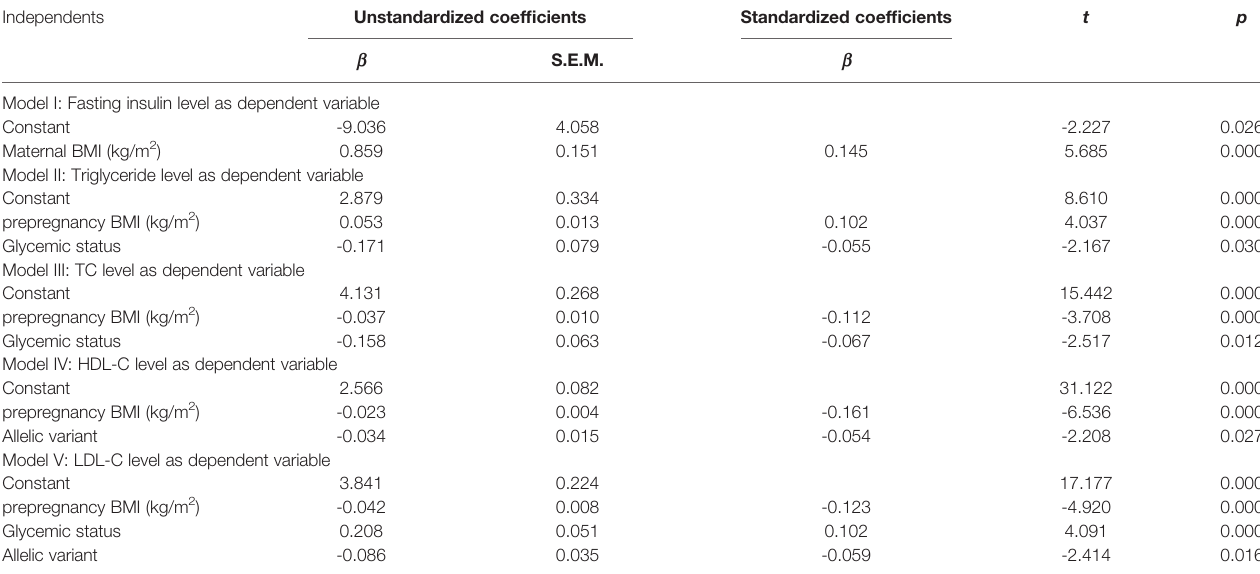
TABLE 7 | Association of important independent predictors/confounders with biomarker levels by multivariate regression analysis in women with and without GDM.